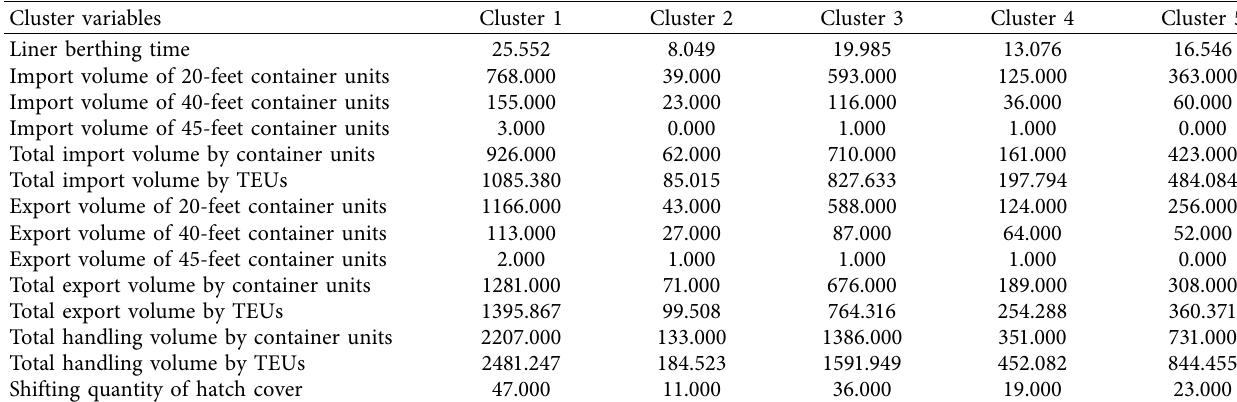
Table 2: Final cluster centers of CTO-LGC log dataset with the six